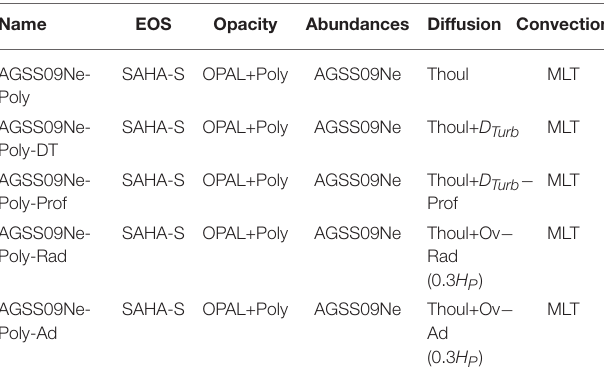
TABLE 3 | Physical ingredients of the solar models with modified opacities and additional mixing used in this